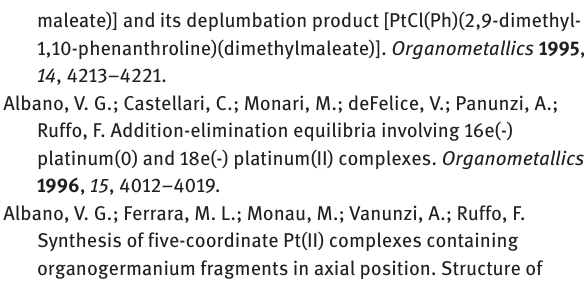
CaCl] (Davidson et al., 4